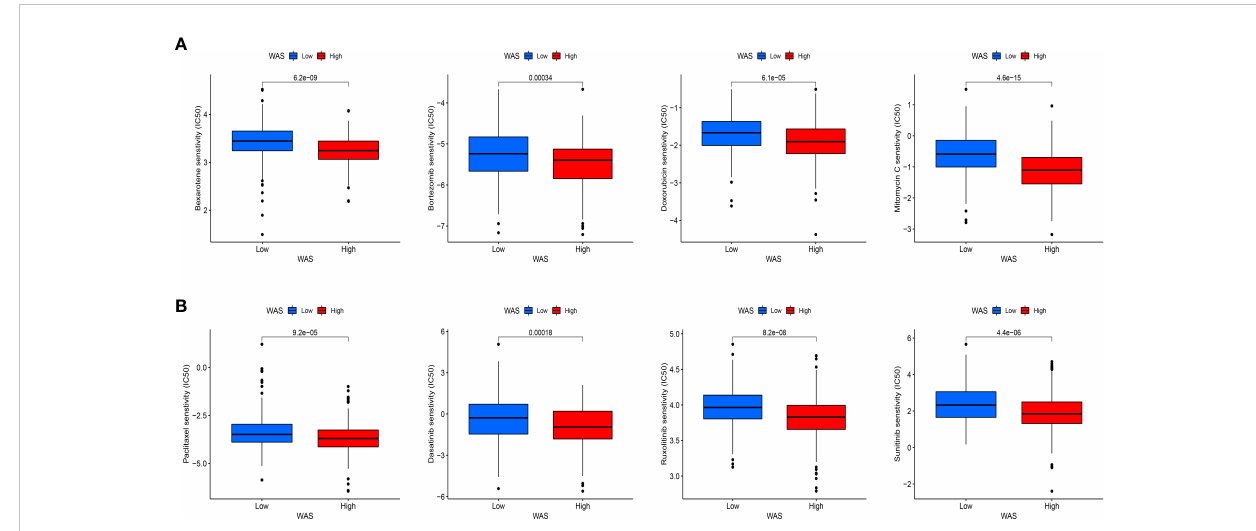
FIGURE 11 Immunotherapeutic and chemotherapeutic responses for high and low WAS expression patients. (A) Boxplots illustrate the immunotherapeutic and chemotherapeutic responses of Bexarotene, Bortezomib, Doxorubicin, and Mitomycin C in different WAS expression patients. (B) Boxplots illustrate the immunotherapeutic and chemotherapeutic responses of Paclitaxel, Ruxolitinib, Dasatinib, and Sunitinib in the high and low WAS expression